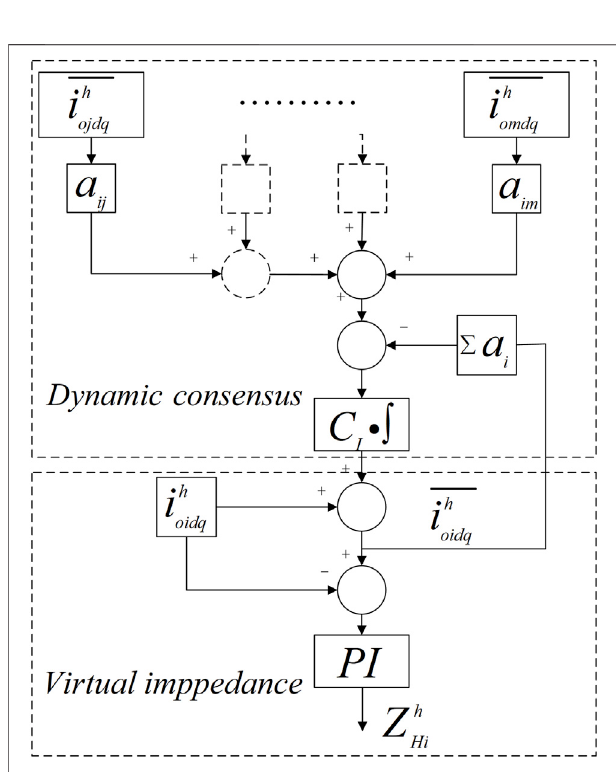
FIGURE 6 | Proposed power sharing based on distributed control.